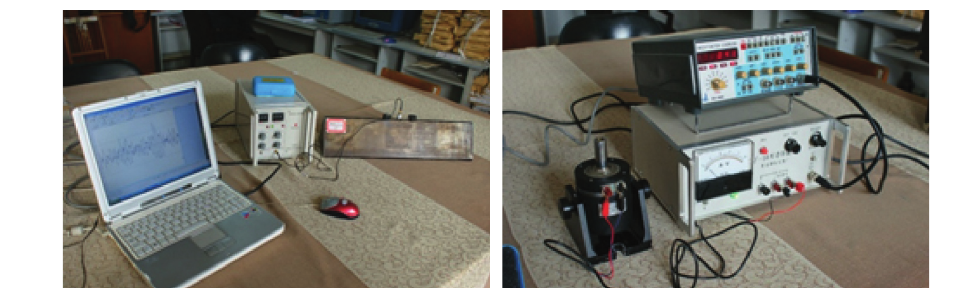
Figure 5: Physical diagram.